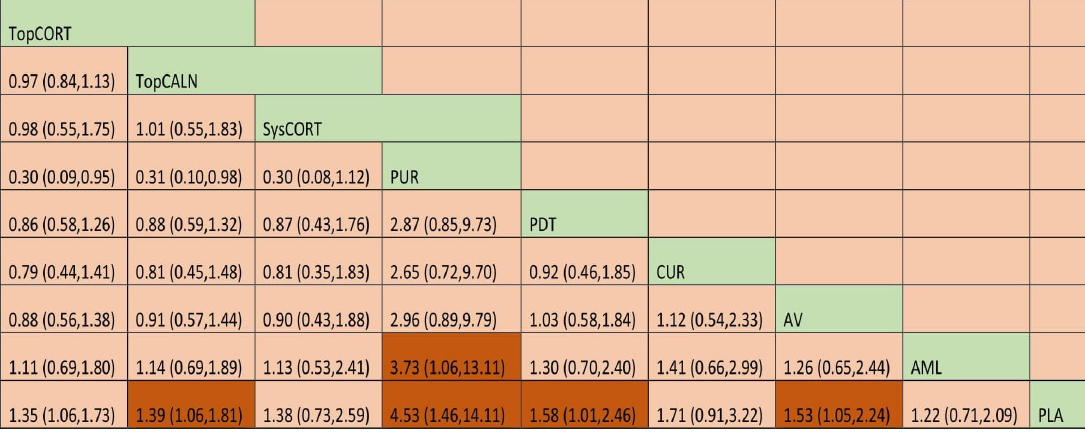
Figure 4. League table for the Clinical Improvement of OLP. Abbreviations: AML, amlexanox paste; AV, aloe vera; CUR, curcumin gel; PDT, photodynamic therapy; PLA, placebo; PUR, purslane; SysCORT, systemic corticosteroid; TopCALN, topical calcineurin; TopCALNcoSysCORT, topical calcineurin combined with systemic corticosteroid; TopCORT, topical corticosteroid. The green gihlights indicate the interventions and the dark highlights indicate the significant results.